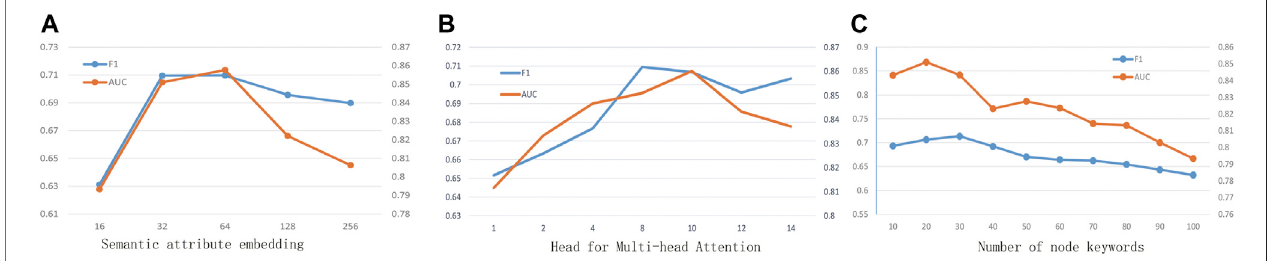
FIGURE 4 | Parameter analysis (A) Semantic attribute embedding. (B) Head for multi-head attention. (C) Number of node Keywords.